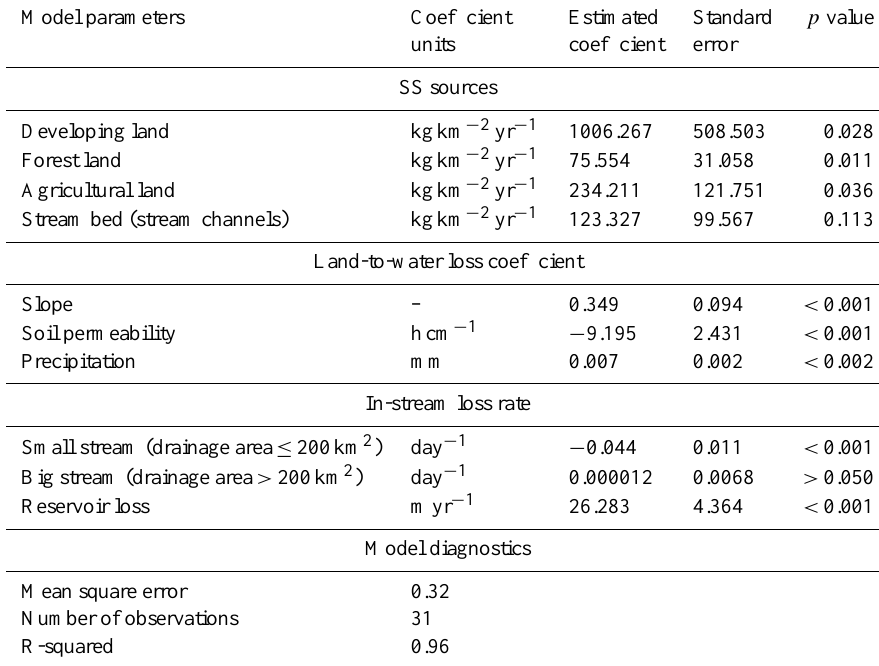
Table 2. SPARROW estimates of model statistics for Ishikari River basin SS.